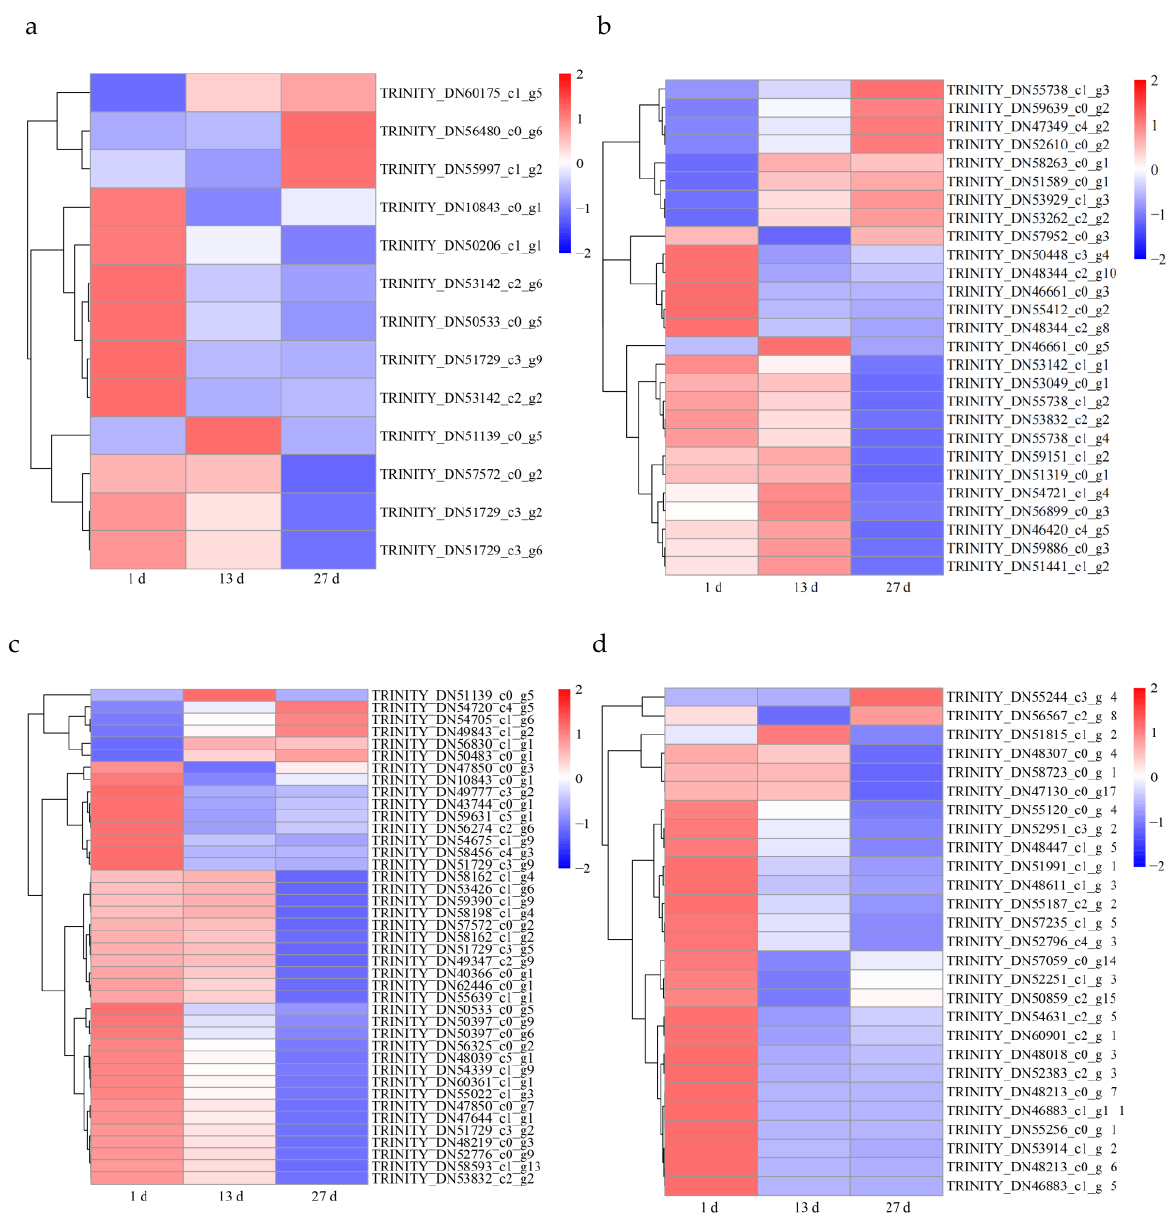
Figure 8. Heatmap diagram of differentially expressed genes (DEGs): peroxide and thioredoxin ( a ); glucose metabolism ( b ); secondary metabolites ( c ); transcription factors ( d